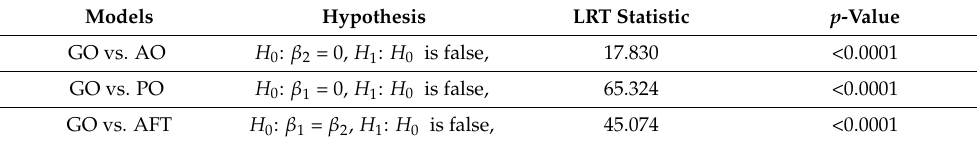
Table 7. LRT values for the GO Model and its sub-models using IPASS dataset.